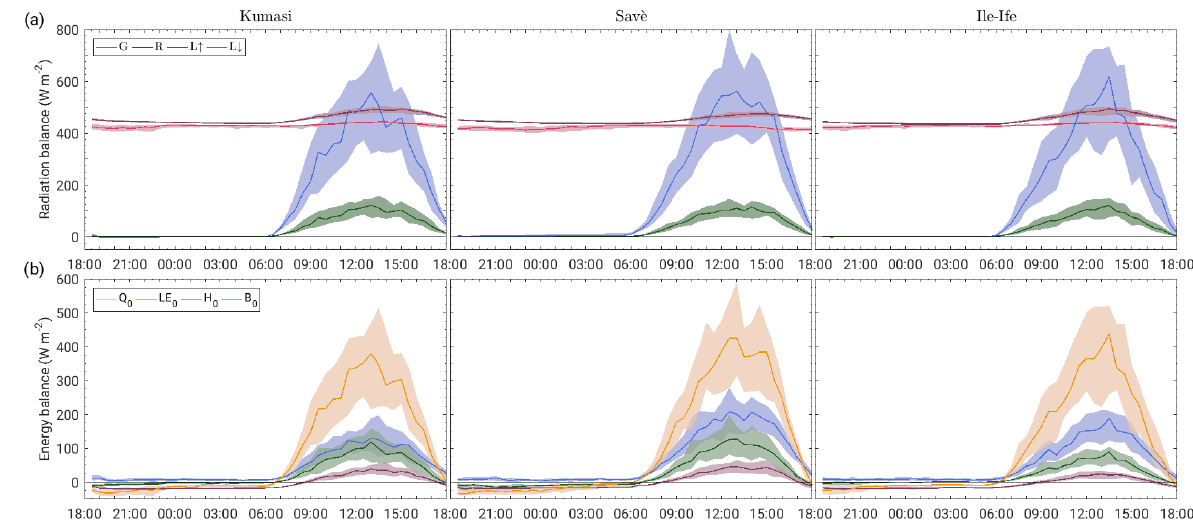
Figure 6. Median diurnal cycles of (a) radiation balance components (radiation: shortwave downward, G ; shortwave upward, R ; longwave downward, L ↓ ; longwave upward, L ↑ ) and (b) energy balance components (net radiation, Q 0 ; sensible heat flux, H 0 ; latent heat flux, LE 0 ; soil heat flux, B 0 ) for Kumasi (left), Savè (middle) and Ile-Ife (right). The shaded areas represent the interquartile ranges.